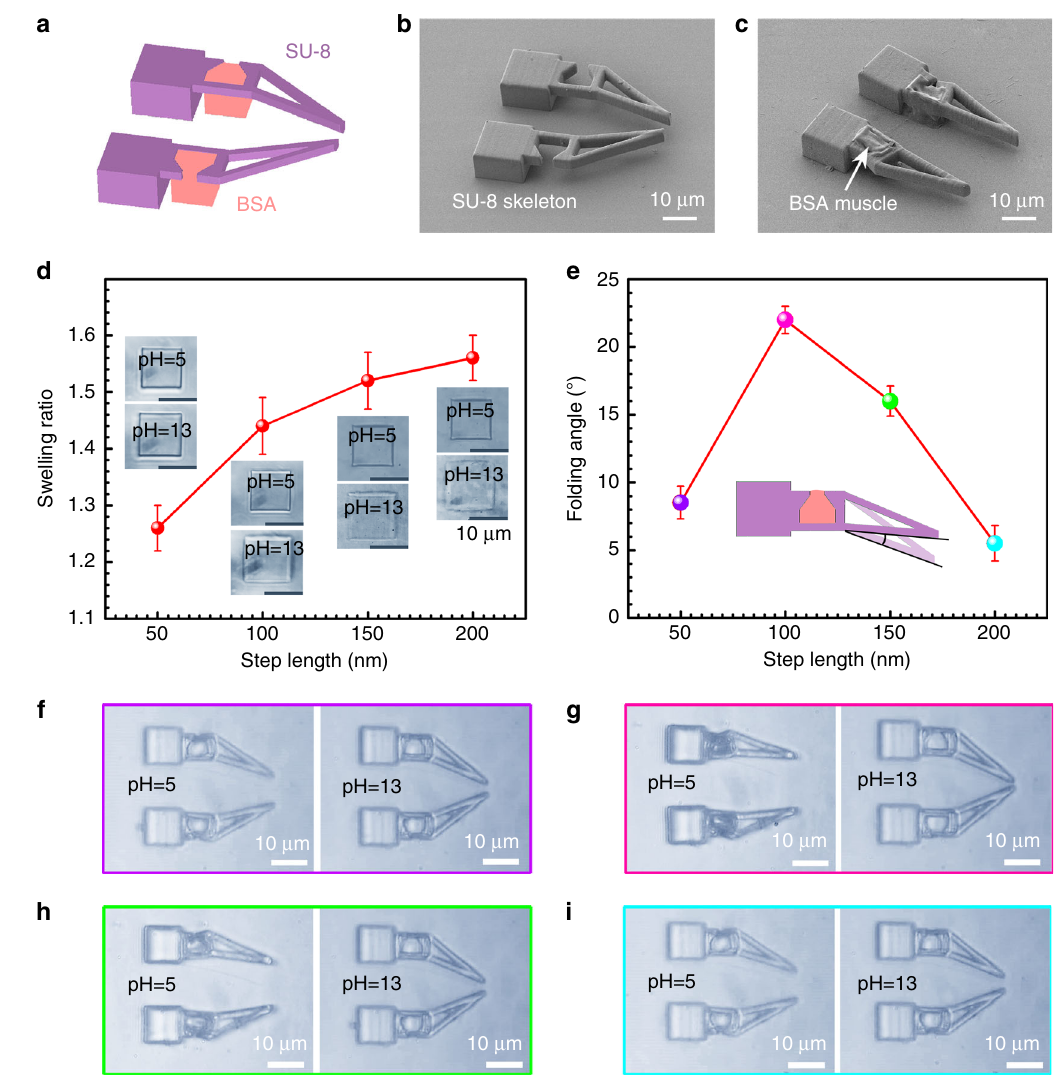
Fig. 4 A pH-driven micro-gripper. a The 3D model of the micro-gripper. b , c SEM images of the micro-gripper before and after the integration of BSA muscles, respectively. d Dependence of the swelling ratio of a BSA micro-block (10 μ m × 10 μ m) on the laser scanning step length (50, 100, 150, and 200 nm) when the pH of the surrounding solution was switched between 5 and 13. The insets are corresponding optical microscopic images of the BSA blocks. e The dependence of the folding angle (one arm of the micro-gripper) on the laser step lengths for the fabrication of BSA muscles. f – i The pH- responsive grapping performance of the micro-grippers with BSA muscles fabricated under the laser step lengths of 50, 100, 150, and 200 nm, respectively. Error bars denote the standard deviation of the measurements. Source data are provided as a Source data fi